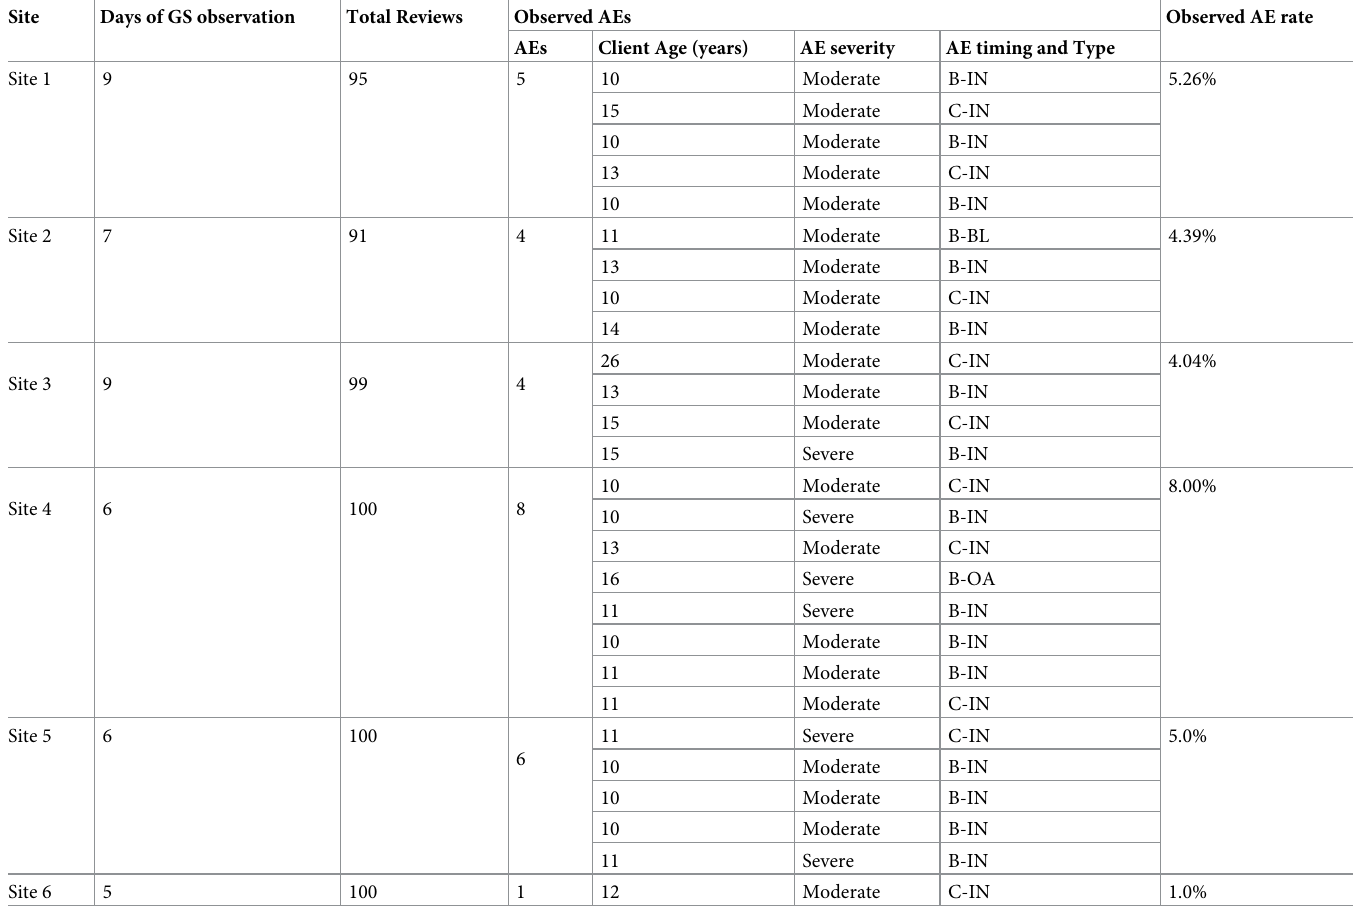
Table 1. Characteristics of the 27 AEs observed during tandem reviews.